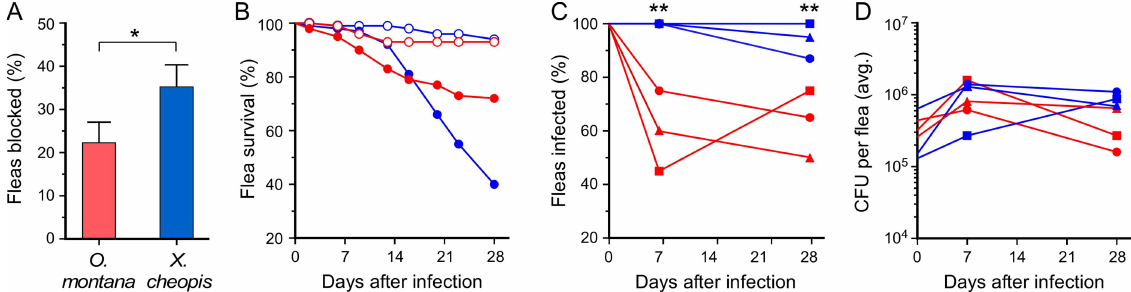
Fig 1. Comparative blockage and infection rates of O . montana and X . cheopis during a four-week period after a single infectious blood meal. ( A ) Percentage of fleas that developedcompleteproventricular blockage.The mean and SD are indicated. ( B ) Mortality rate of uninfected(open symbols) and infected (closed symbols) O . montana (red symbols) and X . cheopis (blue symbols). ( C ) Percentage of O . montana (red symbols) and X . cheopis (blue symbols) still infected 7 and 28 days after an infectious bloodmeal. ( D ) Mean bacterialload in infected O . montana (blue symbols) and X . cheopis (red symbols) immediately after the infectiousblood meal (day 0) and at 7 and 28 days after infection. The cumulativeresults of three independentexperiments (n = 99 to 113 fleas each) are shown in ( A, B ); the results of each of the three experiments are plotted in ( C, D ). * P = 0.0003; ** P < 0.0001 by Fisher’s exact test